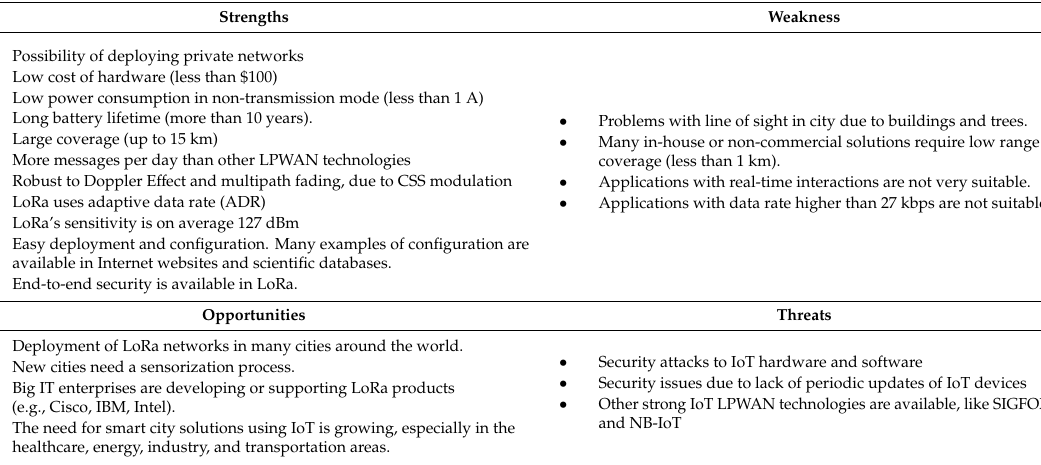
Table 15. SWOT analysis of LoRa in smart city applications.